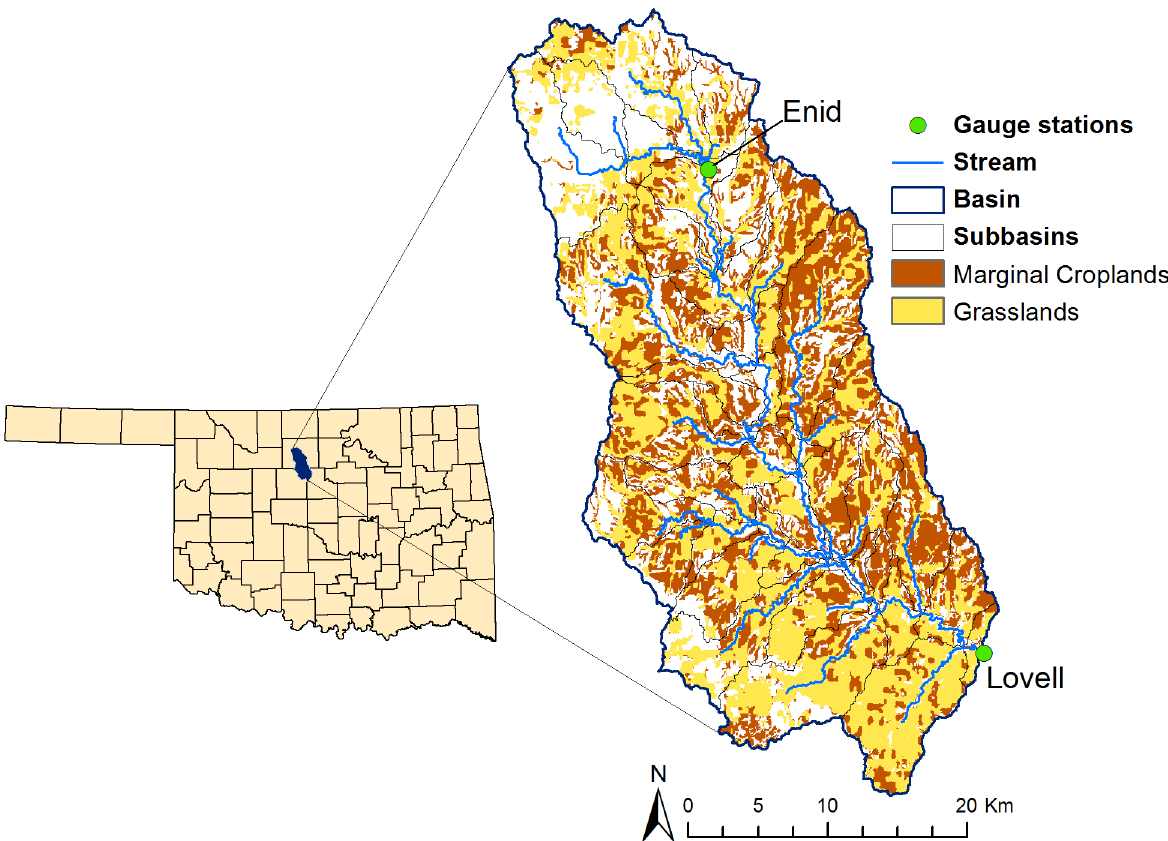
Fig 1. Location of Skeleton Creekwatershed in north central Oklahoma, USA and distribution of grasslands and marginal croplands in the watershed.